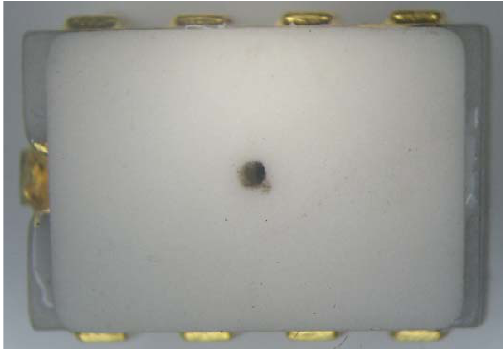
Figure 8. Photograph of a micro pressure sensor after